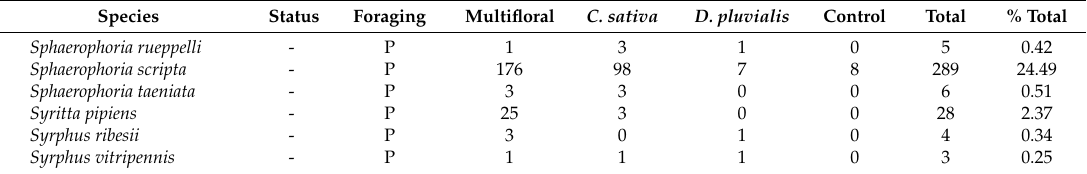
Table 2. Mean abundance and species richness of pollinator community, diversity (Simpson, Shannon and Pielou) depending on the type of collection and pollinator family in each treatment ( ± standard deviation), the degree of freedom (df), Kruskal-Wallis, χ 2 -value and significant differences (*: p -value < 0.05).